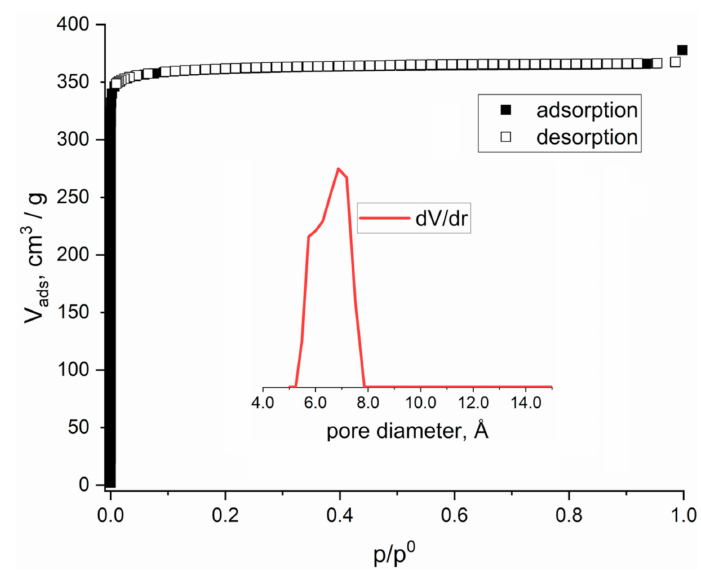
Figure 3. N 2 adsorption isotherm for 1se (cid:48) at 77K and pose-size distribution calculated from the